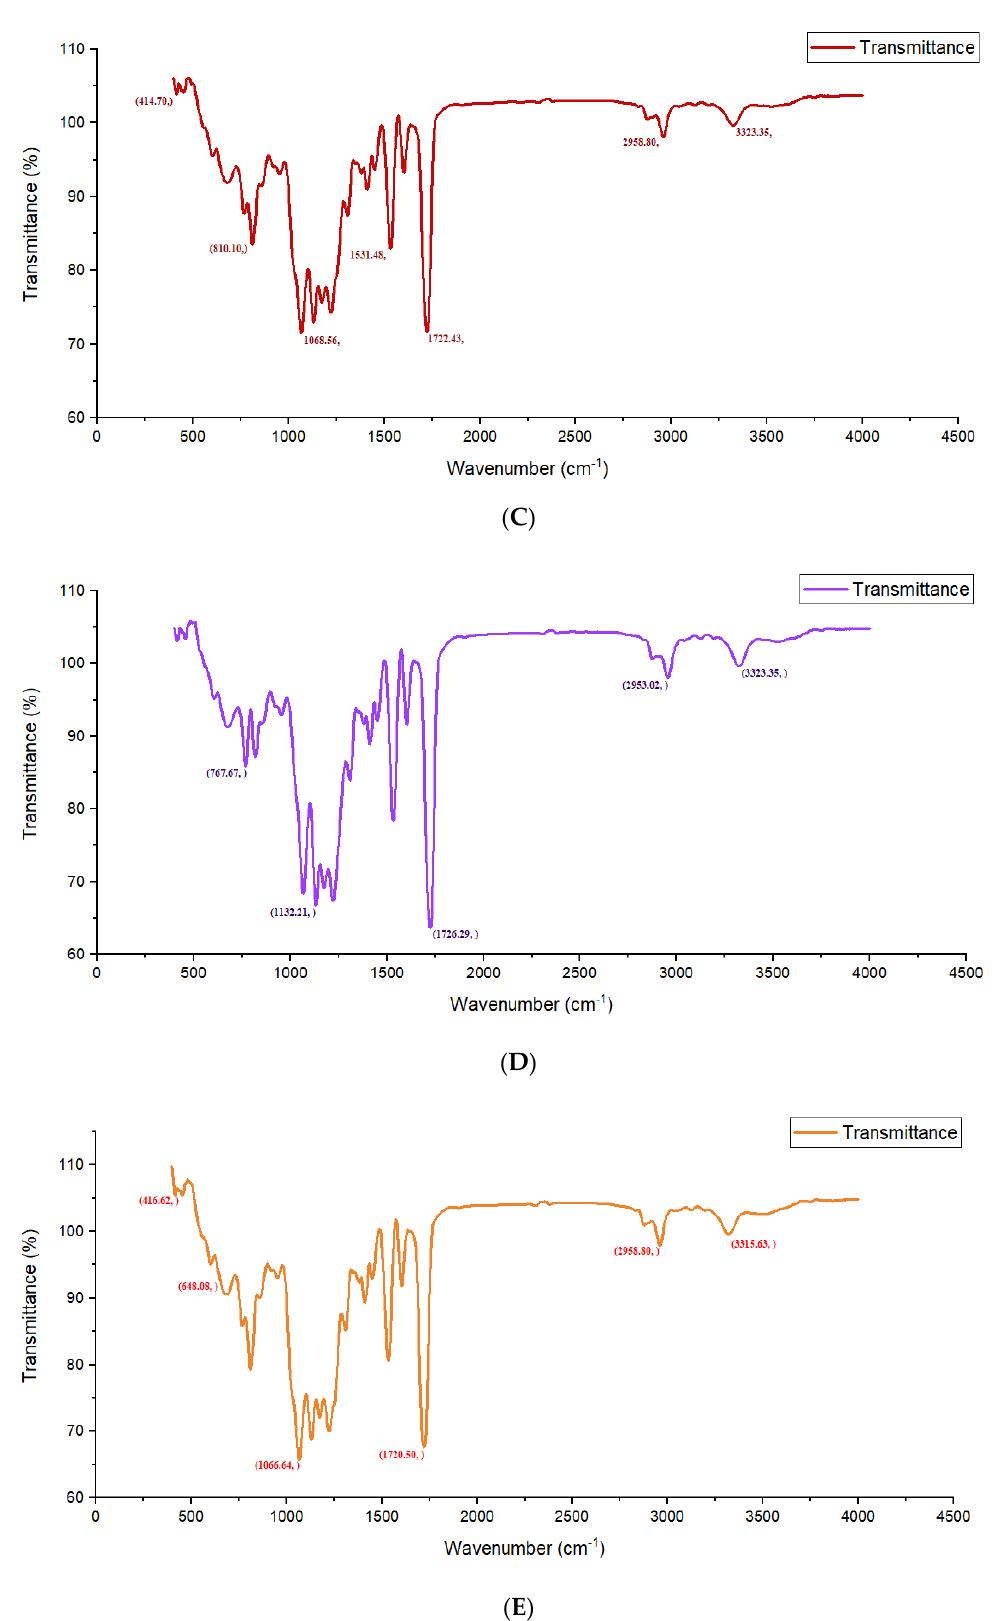
Figure 1. ( A ) FTIR spectra of polyurethane with 4 g concentration of mEG; ( B ) FTIR spectra of polyurethane with 6 g concentration of mEG; ( C ) FTIR spectra of polyurethane with 8 g concentration of mEG; ( D ) FTIR spectra of polyurethane with 10 g concentration of mEG; ( E ) spectra of polyurethane with 12 g concentration of MEG.